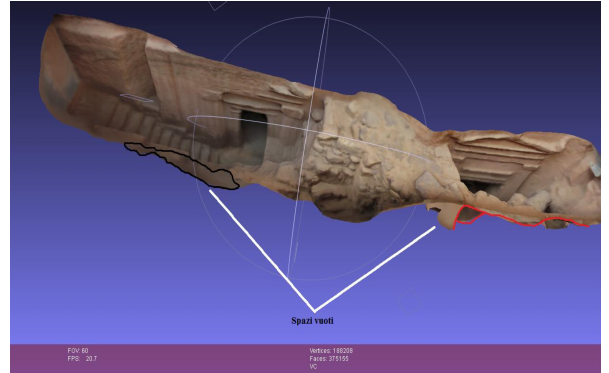
Figure 8. The final result of the reconstruction workflow ends up with the combination of the two doors into one single 3D